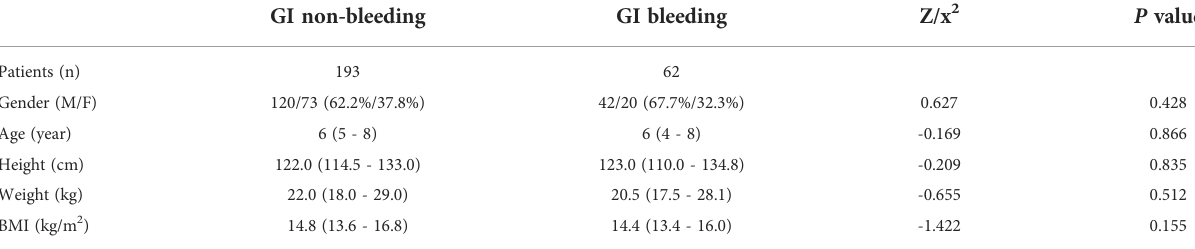
TABLE 1 Demographic characteristics of children in the GI bleeding and GI non-bleeding groups in the training set. GI